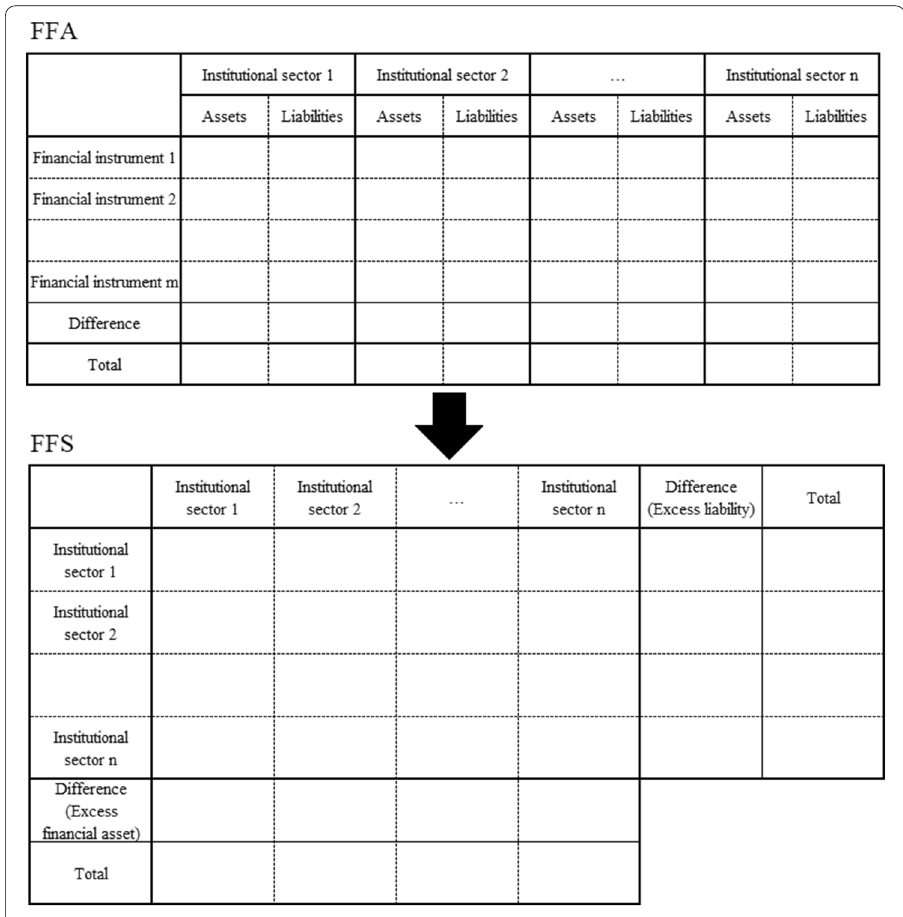
Fig. 1 Conversion of flow of funds accounts into from-whom-to-whom financial